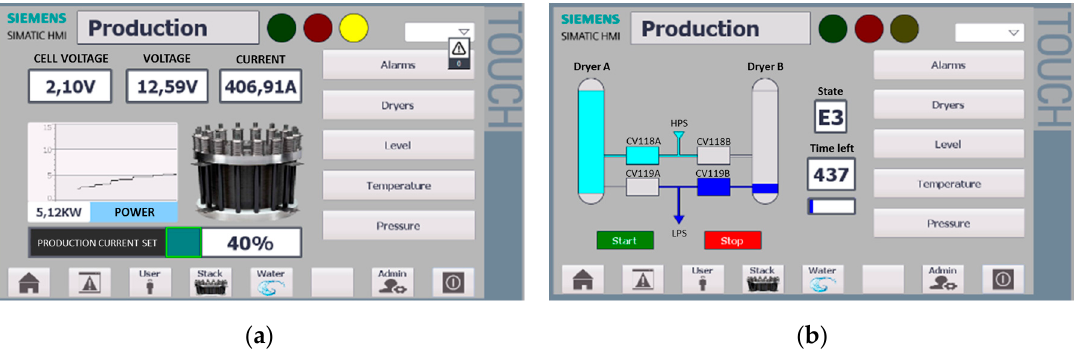
Figure 11. ( a ) Stack power supply subsystem monitoring interface; ( b ) PSA dryers monitoring interface.